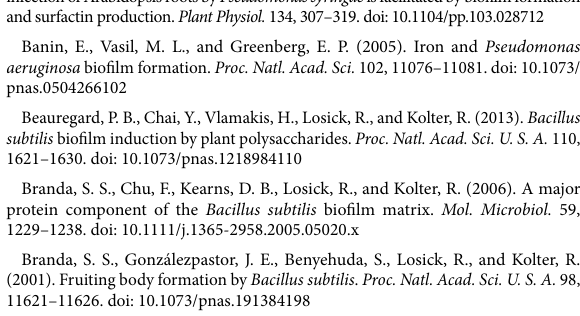
SUPPLEMENTARY FIGURE S1 Colonization of B. subtilis 1JN2 on the root of tomato with (C) or without (B) Cd 2+ treatment. SUPPLEMENTARY FIGURE S2 PCA analysis of the differentially expressed genes of B. subtilis 1JN2 after Cd 2+ treatment. Samples collected at 6h, 12h, 18h, and 24h were named as S2, S3, S4, S5 and the blank control that without Cd 2+ was named as